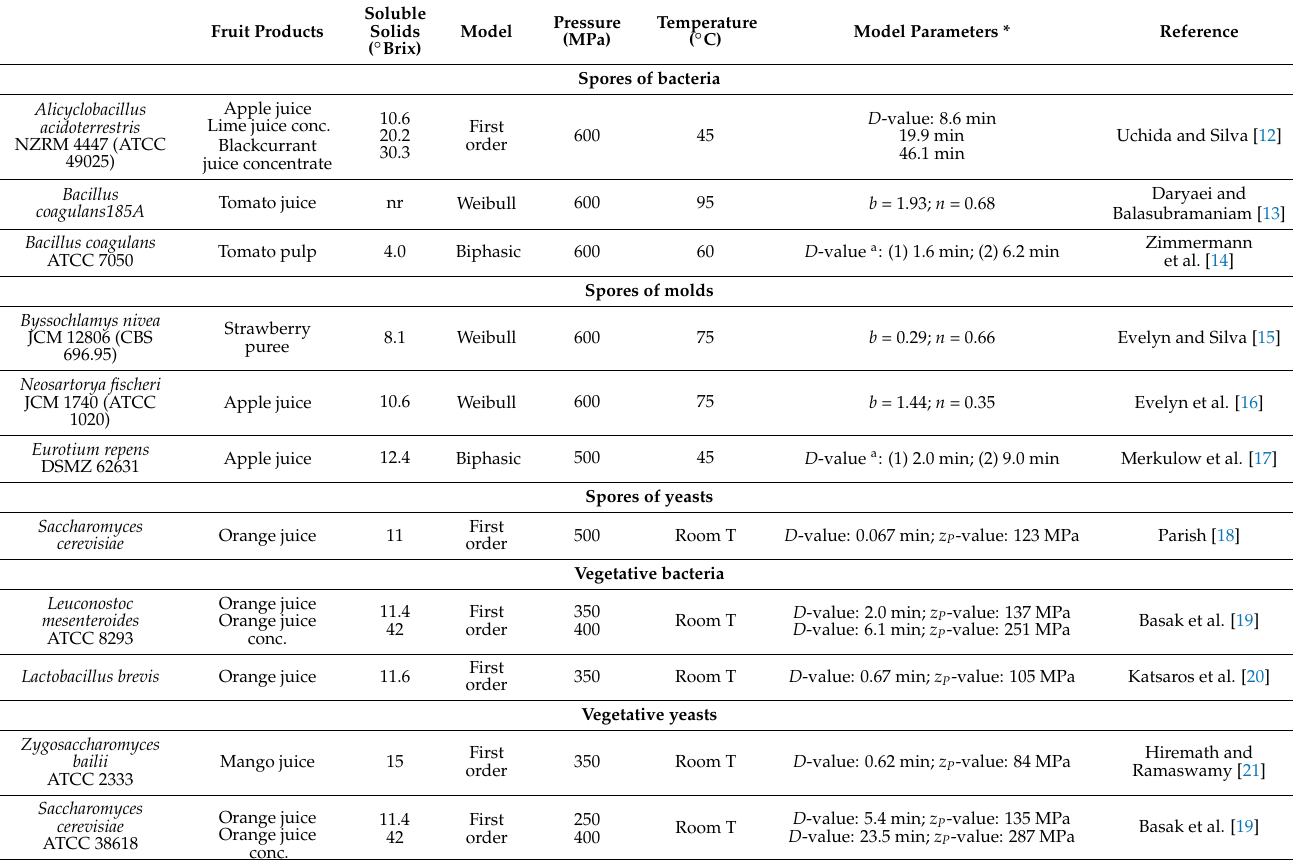
Table 1. Models used to describe different microbes inactivation in fruit products after HPP and